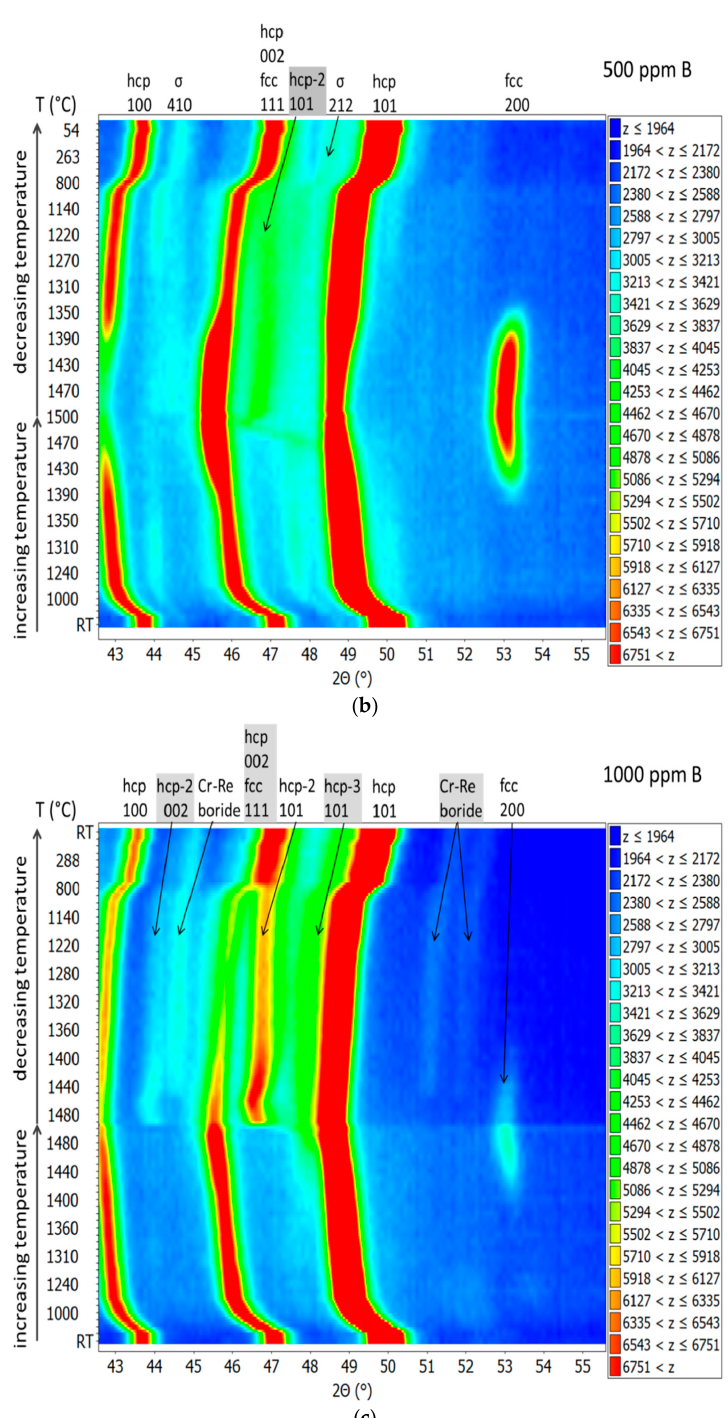
Figure 3. Temperature dependence of the diffractograms for three measured samples: ( a ) 150 ppm B, ( b ) 500 ppm B, and ( c ) 1000 ppm B. The important reflections are marked. The marking on the left denotes the temperature on heating (bottom part) and cooling (upper part). The temperature steps were fine (10 K) in the important temperature region where the matrix transformations occur (i.e., at high temperatures), while they were large at low and intermediate temperatures (from RT up to at 1000 ◦ C). The color-map intensity levels (the color range is shown on the right) were selected in such a way that the weaker reflections are also clearly visible. The graphs are reproduced from [6], with permission from Springer Nature,